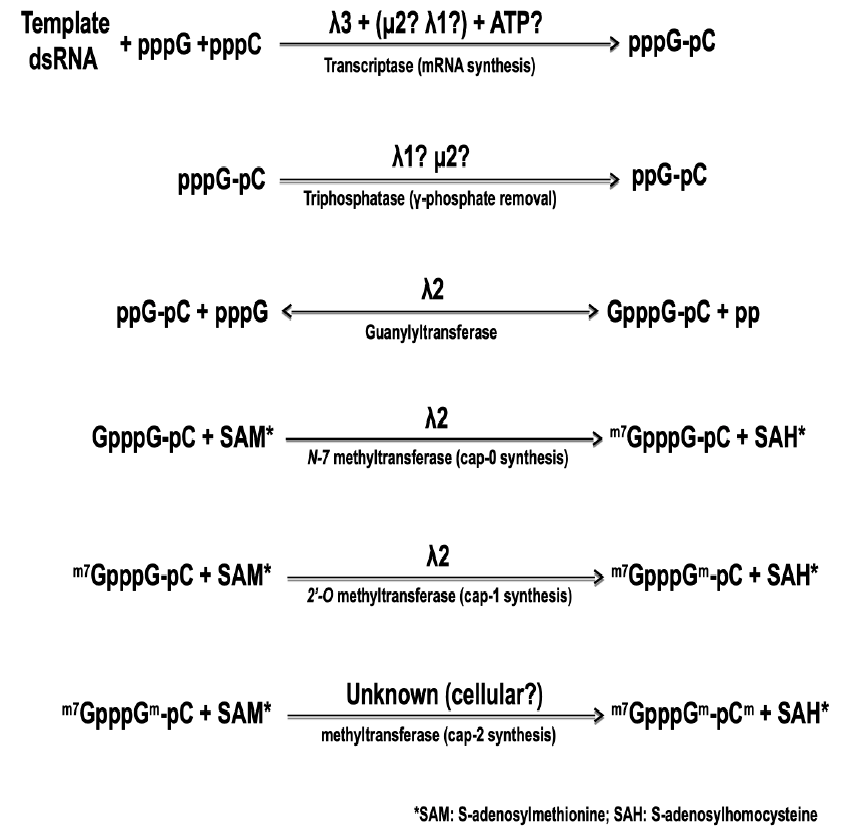
Figure 2. The different steps in the synthesis of capped reovirus mRNA by reovirus core. The nature of the different viral proteins involved is indicated, as described in the text.